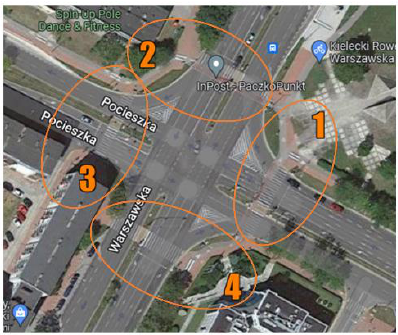
Figure 8. Satellite image of the analyzed intersection with markings of observation sites.